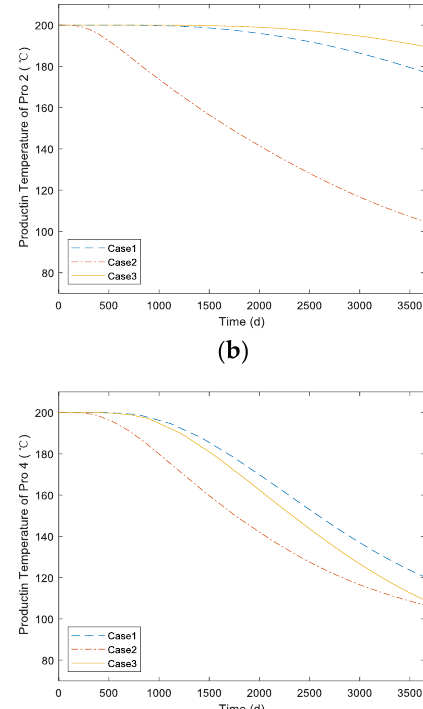
Figure 15. The accumulative extracted thermal energy of the production well ( a ) Pro1 ( b ) Pro2 ( c ) Pro3 ( d ) Pro4.